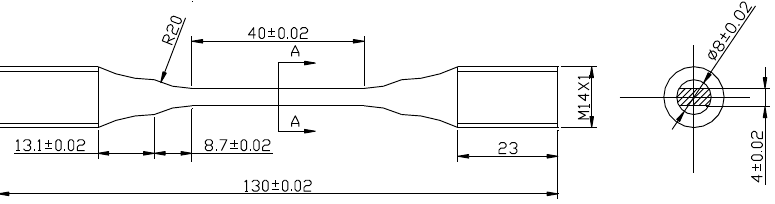
Figure 1. Dimensions and shape of fretting fatigue samples (unit: mm).